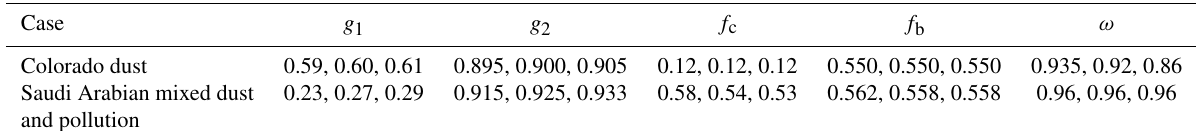
Table 3. Two cases showing the four fitted phase function parameters g 1 , g 2 , f c , and f b as well as single-scattering albedo ω for each of the three reference wavelengths, 615, 546, and 450nm.